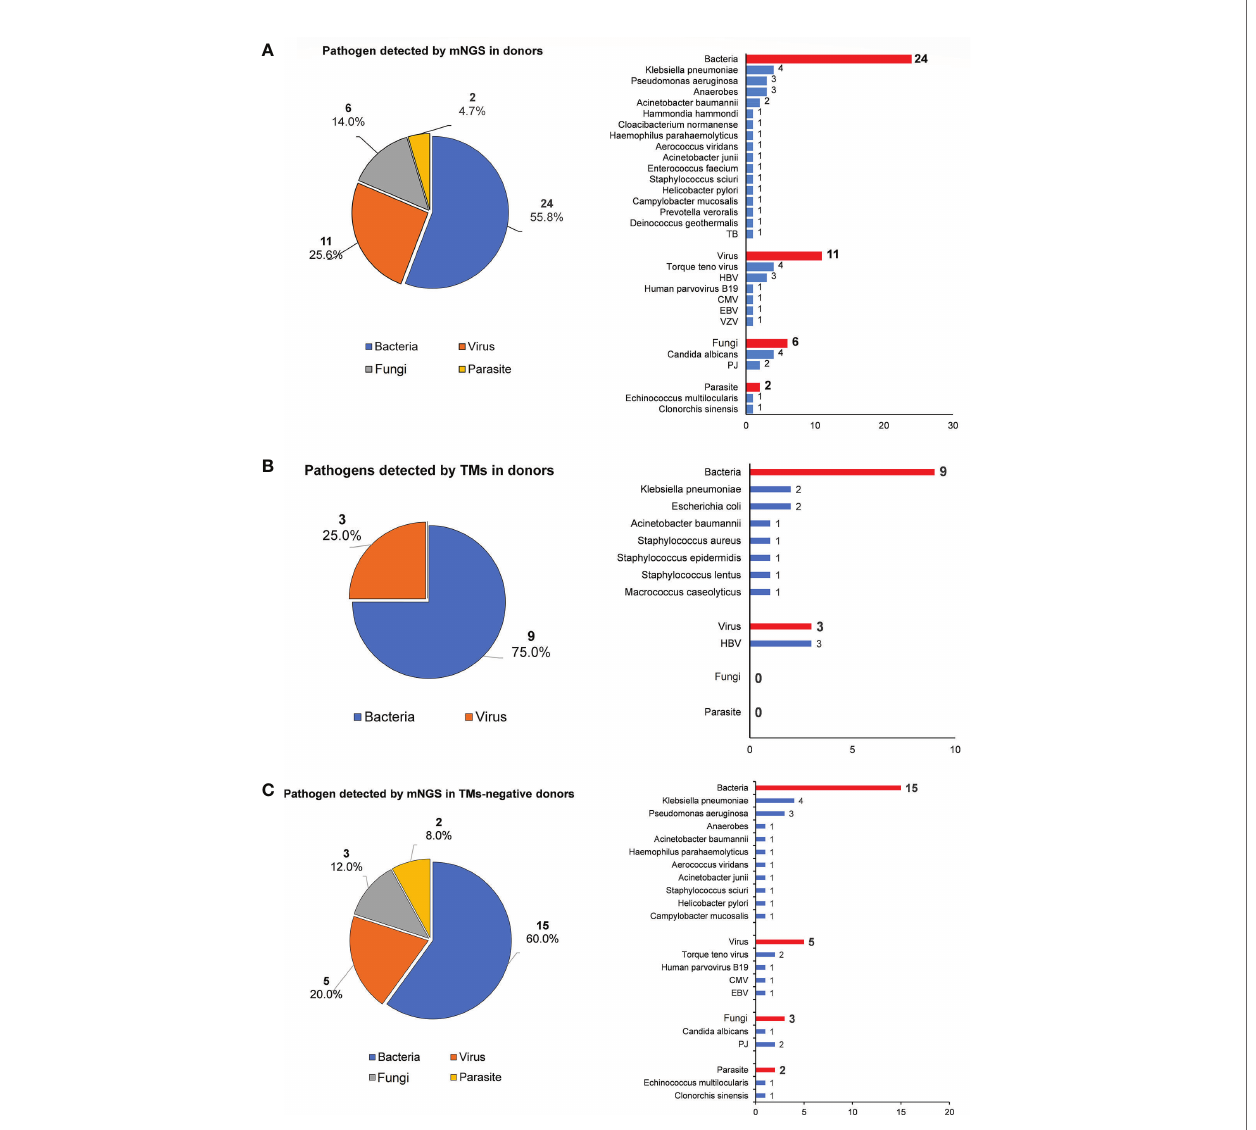
FIGURE 2 | The pathogen spectrum in liver donor detected by mNGS and TMs. (A) Pie chart demonstrating the distribution of different types of pathogens detected by NGS in liver donors, and a total of 43 species of pathogens were detected in donor samples with their corresponding frequencies plotted in histograms. (B) Pie chare demonstrating the distribution of different types of pathogens detected by TMs in donors, and a total of 12 species of pathogens were detected in donor samples with their corresponding frequencies plotted in histograms. (C) Pie chart shows the distribution of different types of pathogens detected in TMs-negative donor samples by mNGS, and species of pathogens were detected with their corresponding frequencies plotted in